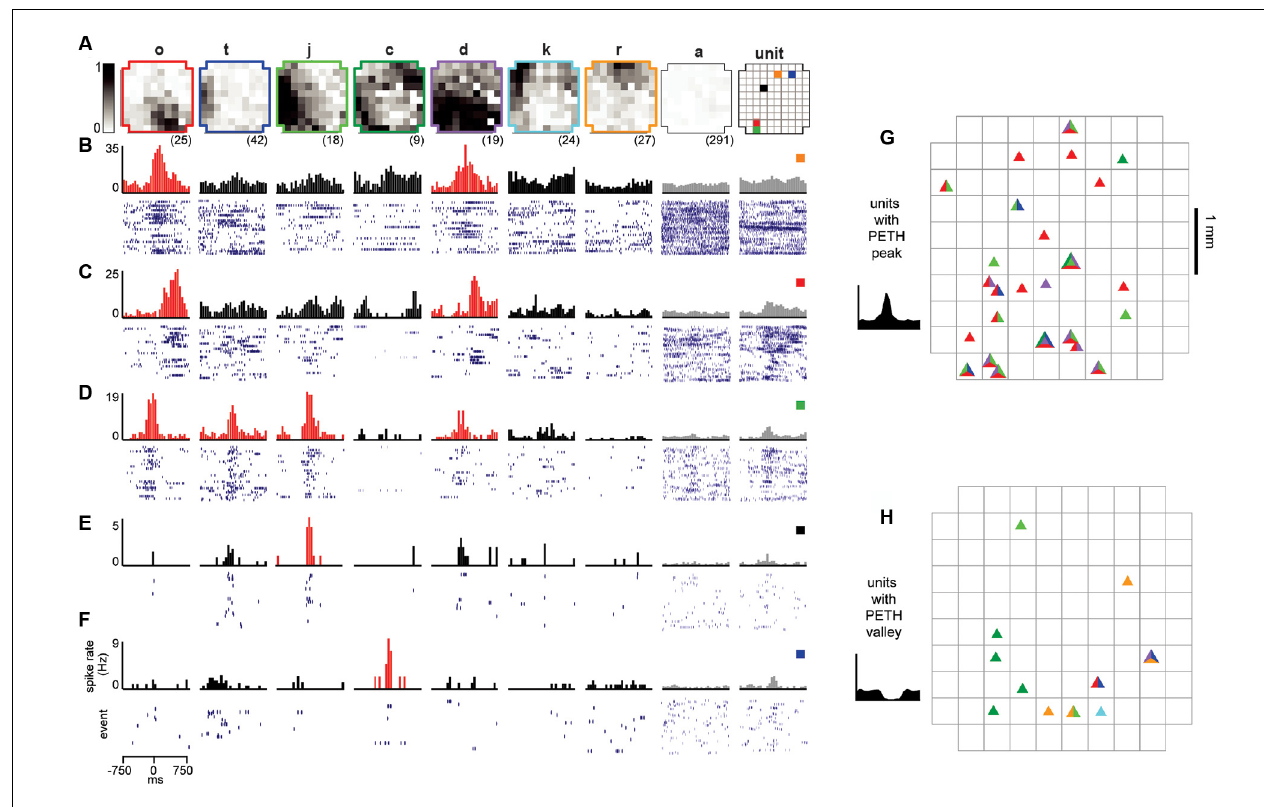
FIGURE 3 | Reliable ensembles of spiking units underlie avalanche families. (A) The average pattern for eight example avalanche families. Letter family labels correspond to Figures 2E,F of monkey 1. Grayscale indicates the fraction of events in which the site participated. Right: color code for locations of units in panels (B–F) . (B–F) Each column displays family-triggered spike rate PETHs (top) and spike rasters (bottom) for five example units. For example, the left-most PETH and spike raster in (B) indicates that this unit increases its firing rate selectively during the occurrence of family o . The temporal bin width for the PETHs was 50 ms. The second to right column shows the average response to avalanches of size 1 (pattern a), excluding large avalanche families. The right-most column includes PETHs and rasters triggered on all nLFPs recorded at the same site as the unit, disregarding family categorization. Red histograms indicate the family specificity of the unit. (G,H) Array location of units (triangles) that selectively increased (G) or decreases (H) their firing in response to families shown in panel (A) . The colors within each triangle indicate which families the unit was selective